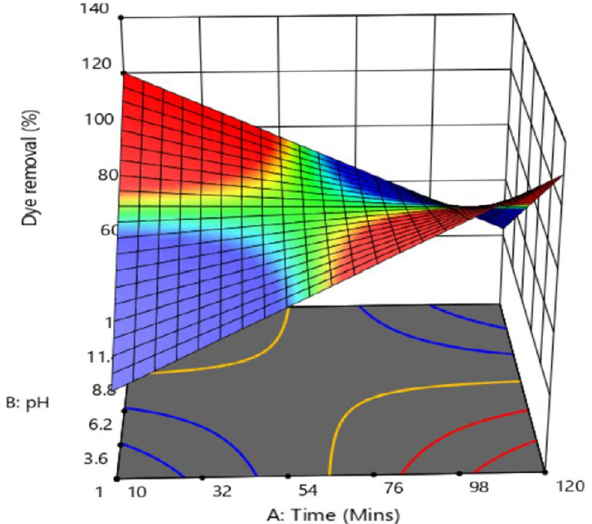
Fig. 18 Surface view showing the relation relative variation of per- centage dye removal with pH and time